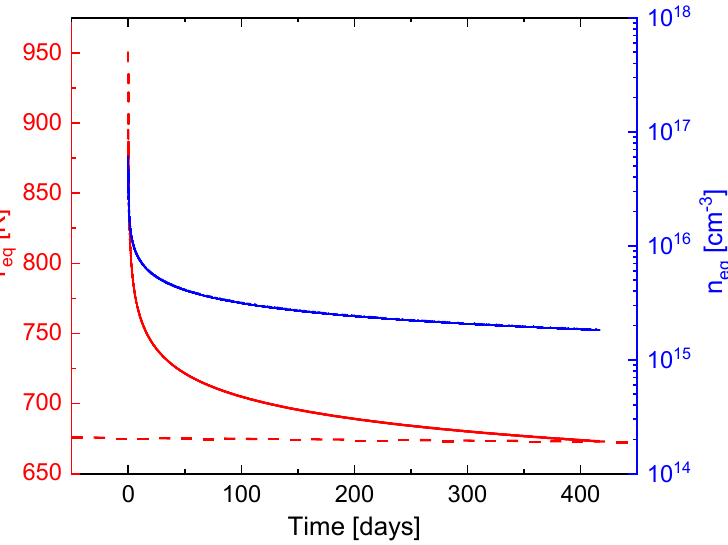
Figure 5. (Red line) Equilibration temperatures reached after times τ eq ; (Blue line) equilibrated charge carrier density in the conduction band after times τ eq . Thermal equilibrium at the MOX sensor operation temperature is reached after about 4 × 10 7 s ≈ 400 days. Up to this point, a considerable drop in the bulk charge carrier density will have occurred. From both lines in Figure 5, it becomes evident that a considerable part of the equilibra- tion does take place in the initial phases after high-temperature materials preparation and cool-down to storage conditions. During these initial phases of cooldown, the volume den- sity of oxygen vacancy donors rapidly equilibrates to the increasingly lower temperatures until equilibration rates become too slow to allow for further equilibration to continuously lower temperatures. This condition is met after a time τ qe , after which the oxygen vacancy donor density has dropped to an equilibrium value corresponding to a temperature.